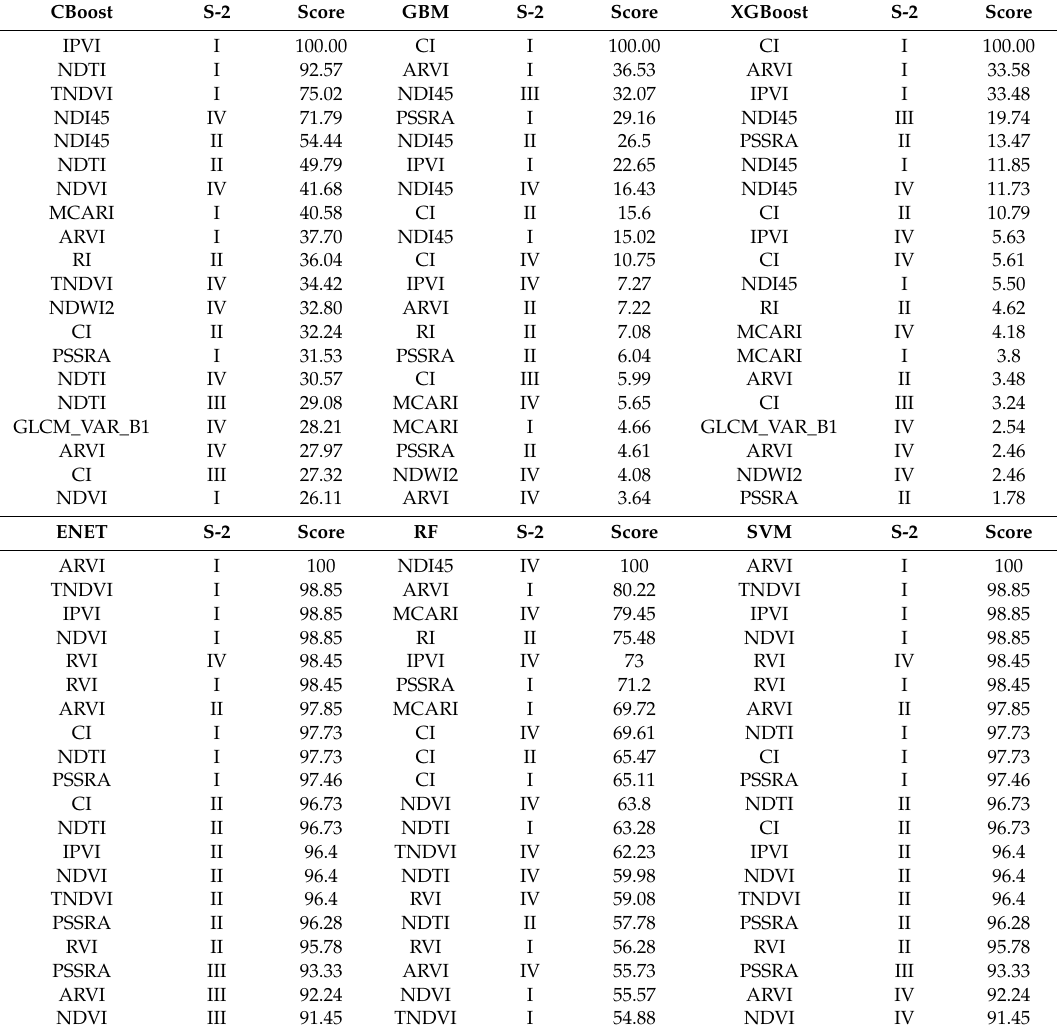
Table 7. Variable importance scores for the top 20 satellite indices and related models. The S-2 columns refer to the positioning of the index variable in the multitemporal set (I = 25 July